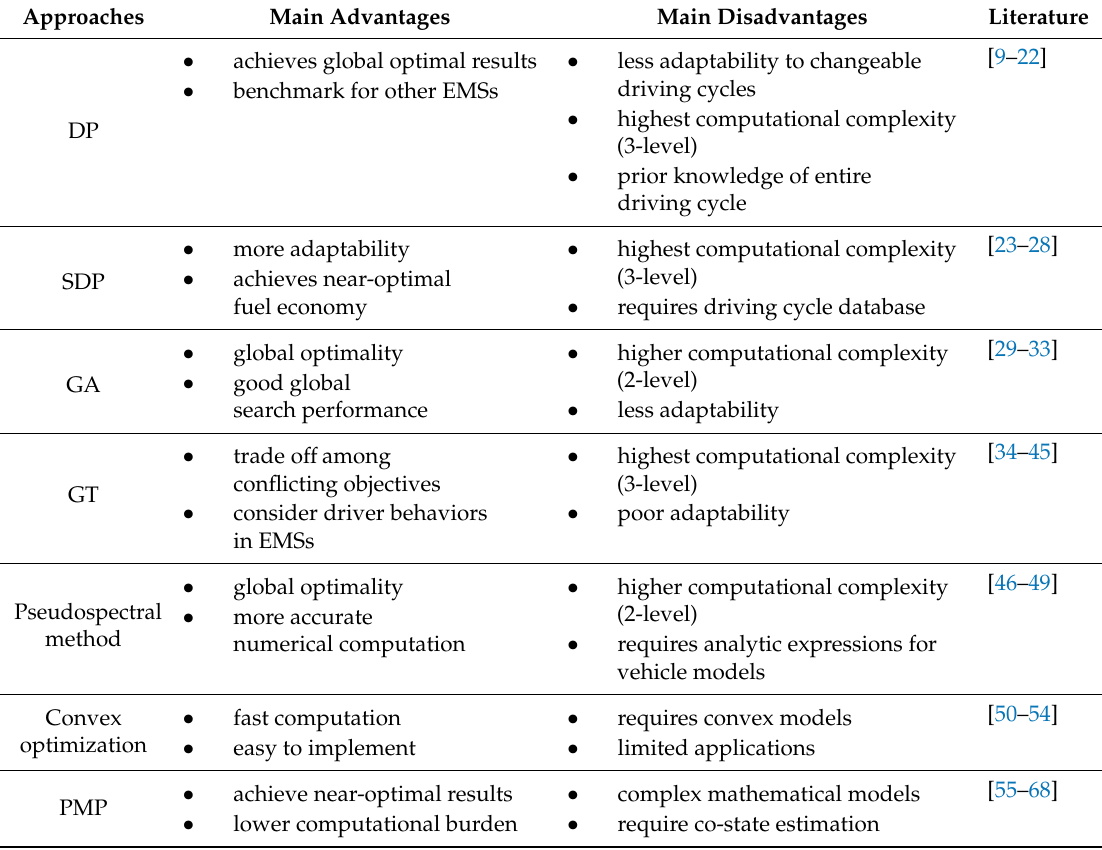
Table 1. Comparison of di ff erent